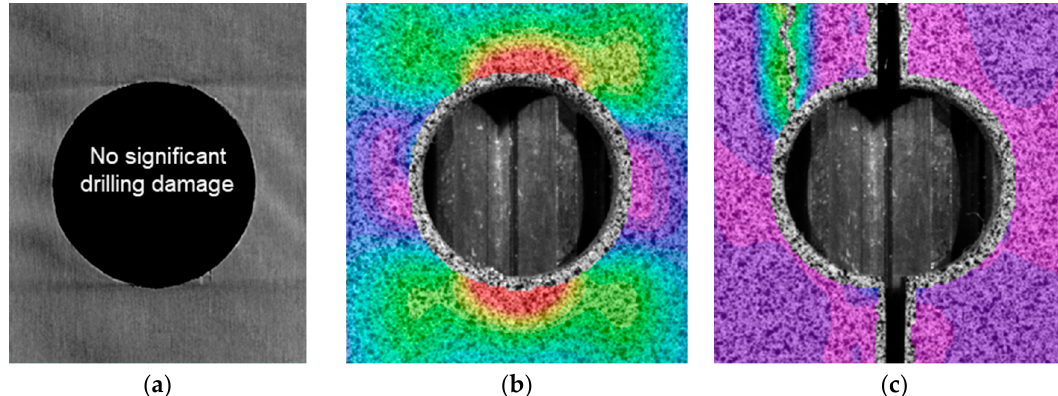
Figure 18. ( a ) ross-sectional CT data prior to testing, ( b ) DIC-measured ILT strain distribution and ( c ) failure mode in a unidirectional tape specimen with acceptable failure mode.